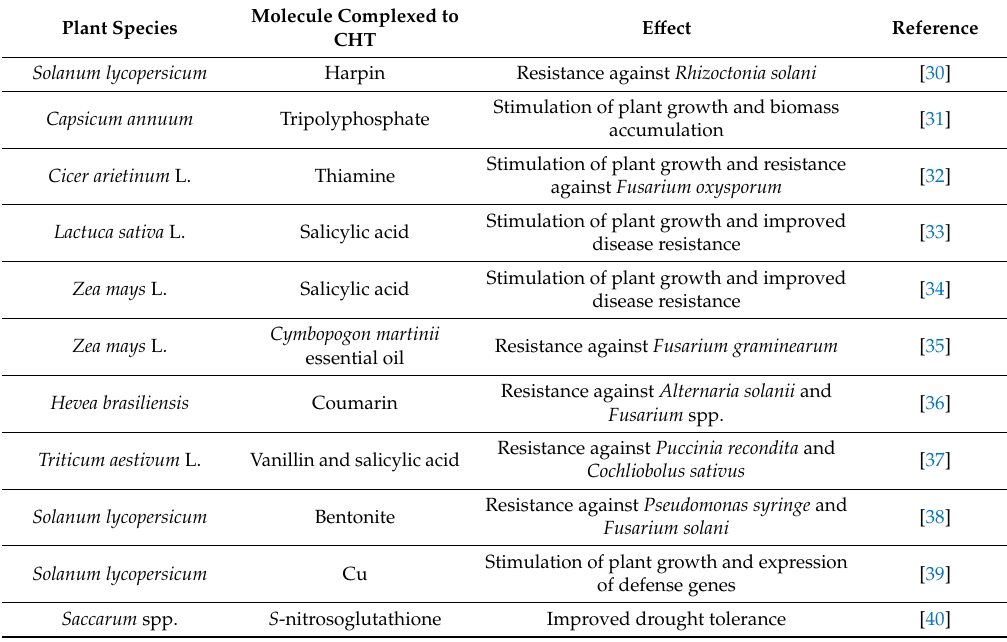
Table 3. Recent application of CHT-based polymers and nanoparticles complexed with di ff erent molecules.